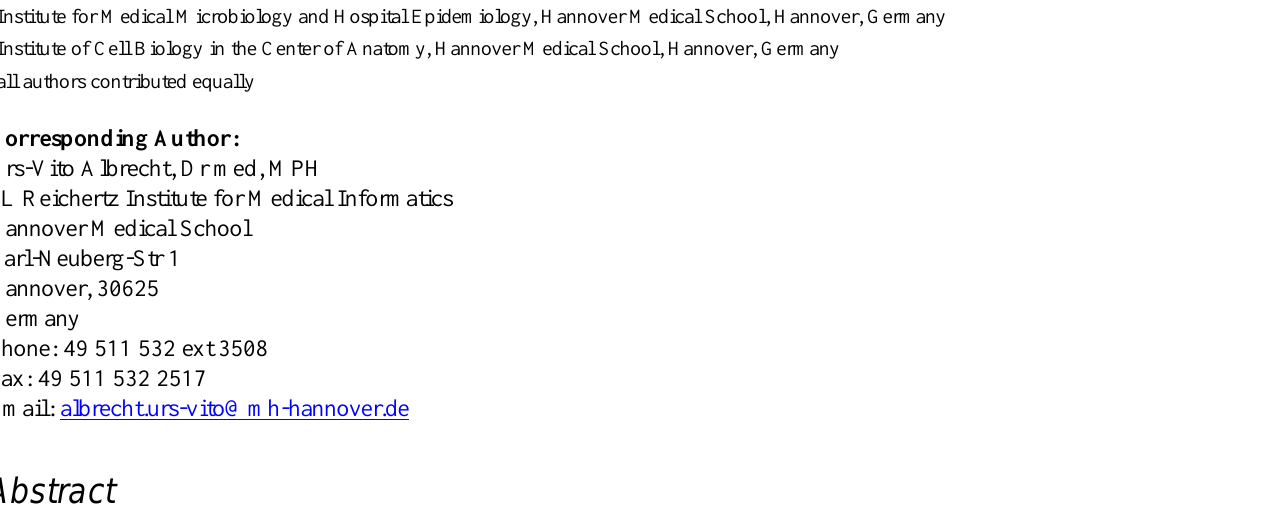
tablet PC; hygiene; disinfection; hygiene; nosocomial